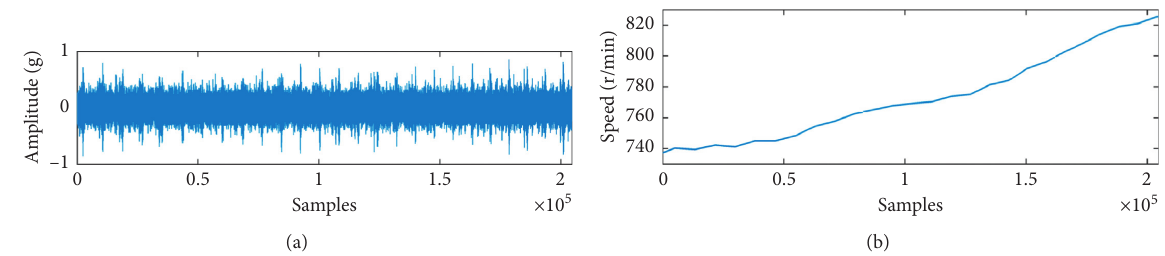
Figure 18: Fault in the inner race: (a) waveform of vibration; (b) speed